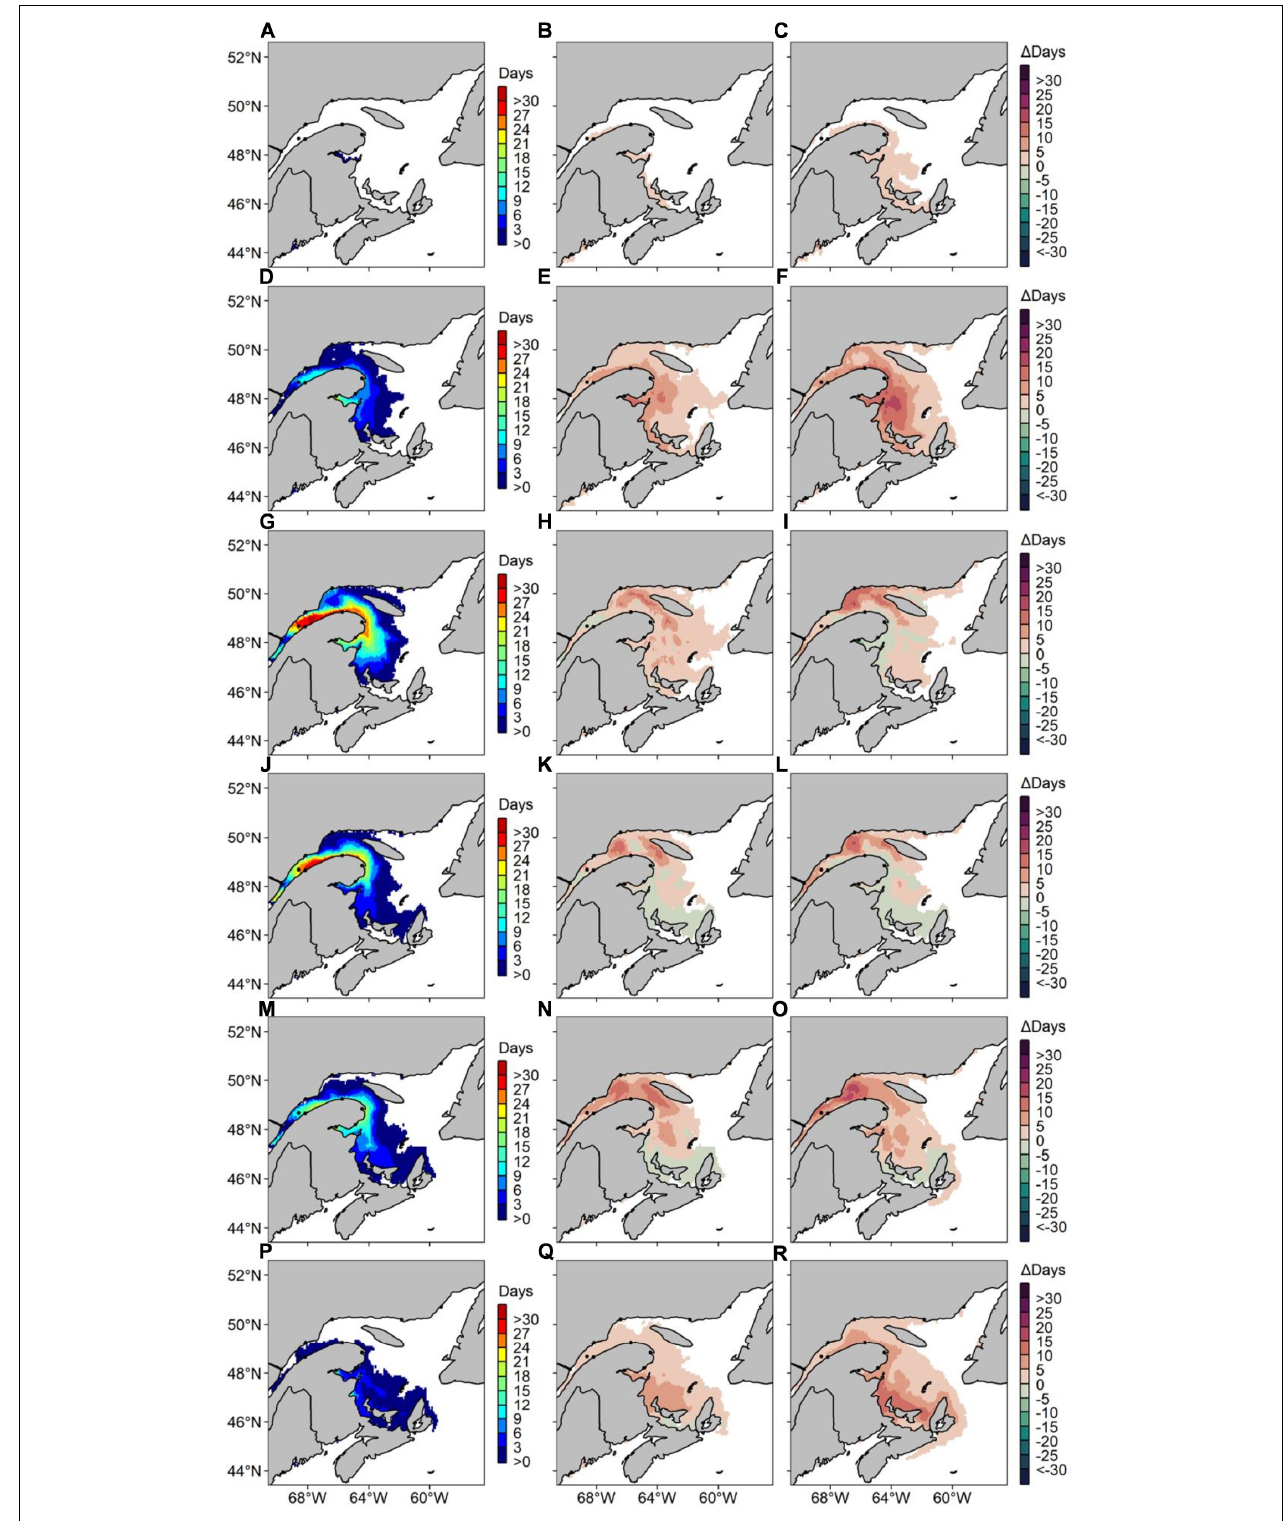
FIGURE 6 | Average number of risk days with Alexandrium catenella ≥ 1000 cells L − 1 along Canada’s East coast under MPI-ESM-LR RCP 4.5 for (A) May 1999–2008, (B) difference in average number of risk days between May 1999–2008 and May 2050–2059 and (C) difference in average number of risk days between May 1999–2008 and May 2090–2099. Same pattern applies for (D–F) June, (G–I) July, (J–L) August, (M–O) September, and (P–R) October.